Question: Draft a figure caption describing what is shown.
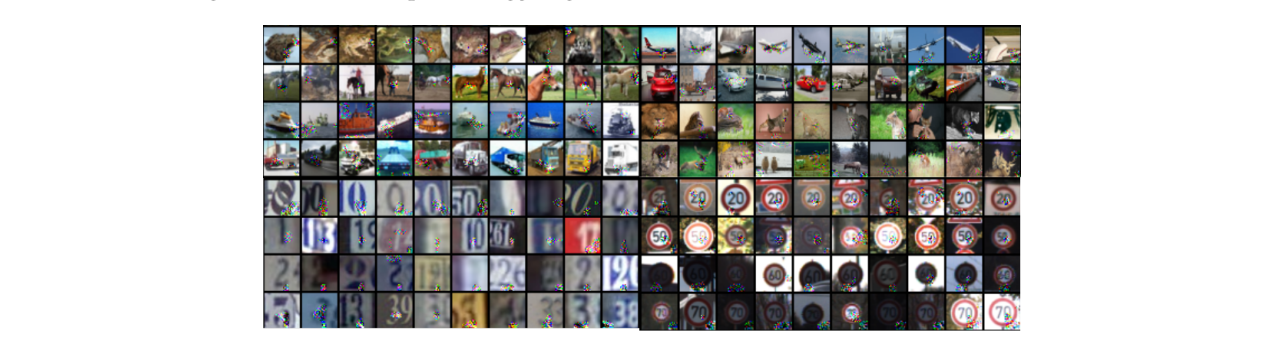
Answer: More examples of triggers generated with the contribution of 𝐿𝑃𝐼𝑃𝑆in the loss and the initialization of the trigger with the original values of the image.